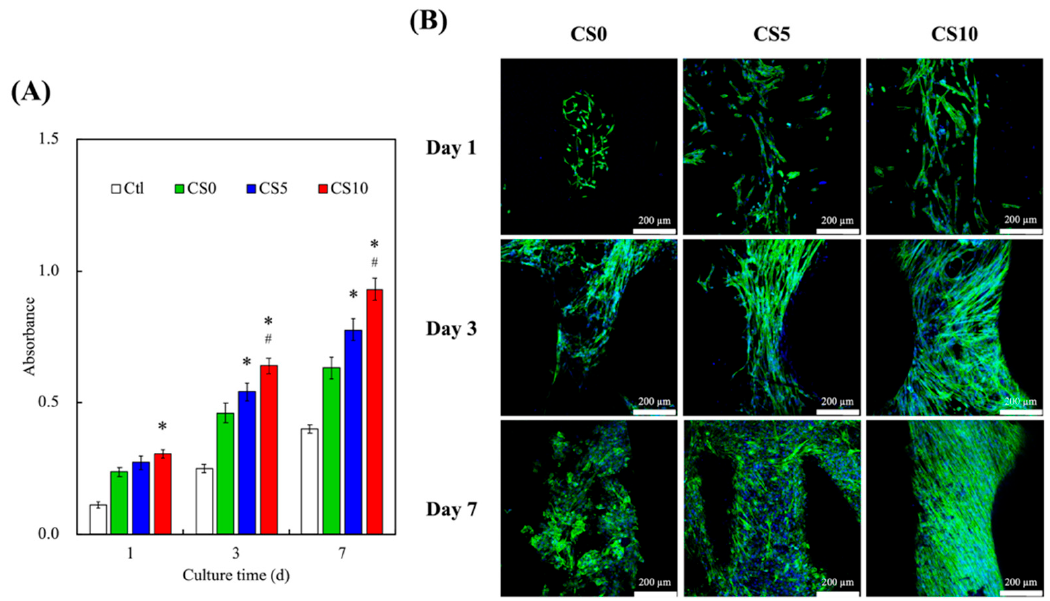
Figure 7. ( A ) Cell proliferation and ( B ) F-actin (green) and DAPI (blue) staining of hDPSCs on the CS-contained GelMa 3D scaffolds at various time points. * indicates a significant difference ( p < 0.05) when compared to CS0. # indicates a significant difference ( p < 0.05) when compared to CS5. The scale bar is 200 µ m.